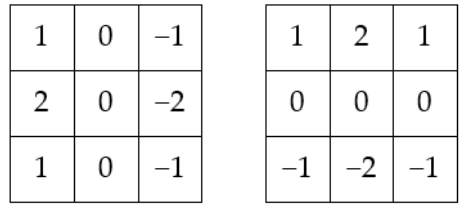
Figure 1. Horizontal and vertical Sobel kernels.